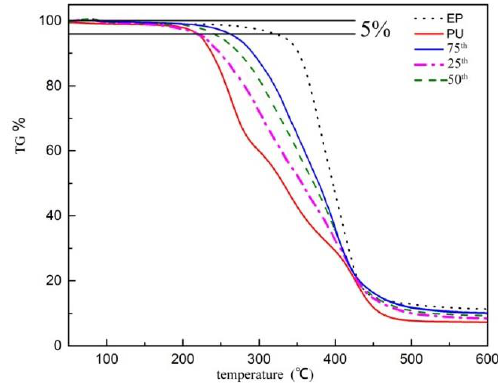
Figure 6. Thermogravimetric (TG) curves of epoxy (EP), polyurethane (PU) and the chosen layers from the gradient IPN sample. Heating rate: 10.0 °C/min, air atmosphere.